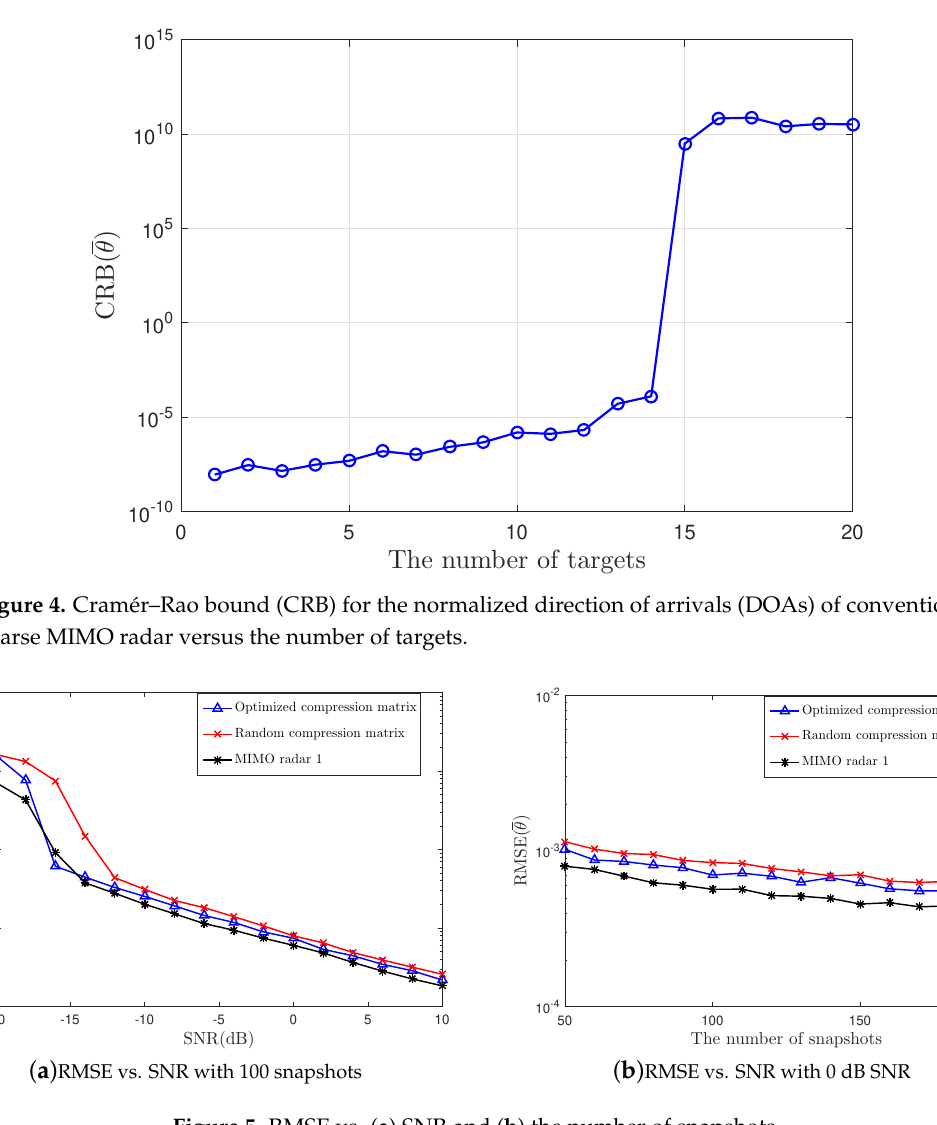
Figure 5. RMSE vs. ( a ) SNR and ( b ) the number of